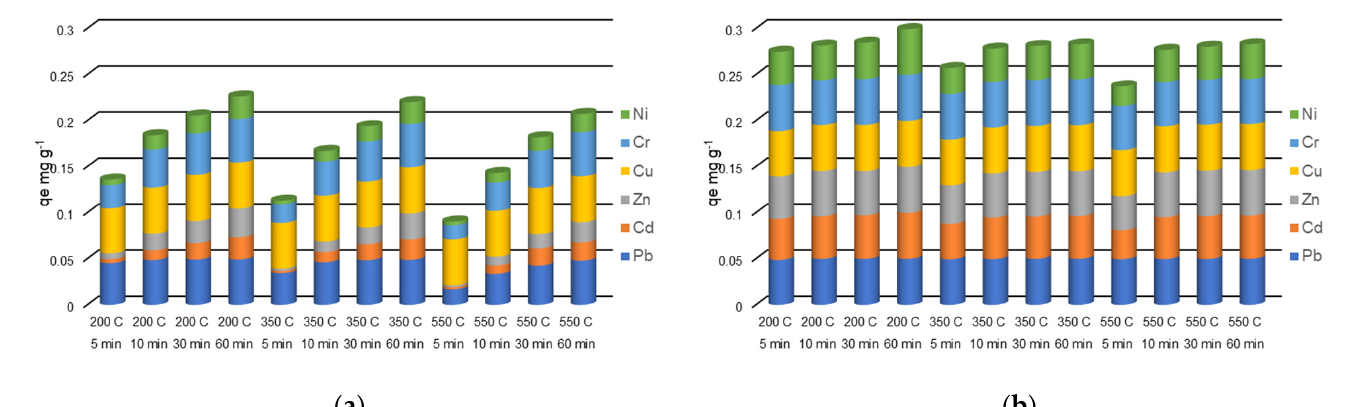
Figure 5. Heavy metals amount in the adsorbent phase q e (mg g − 1 ) with a grain size of 1–3 mm ( a ), and 0–0.05 mm ( b ), thermally treated adsorbed from multicomponent solutions of 5 mg L − 1 at four different contact times (5, 10, 30, 60 min).